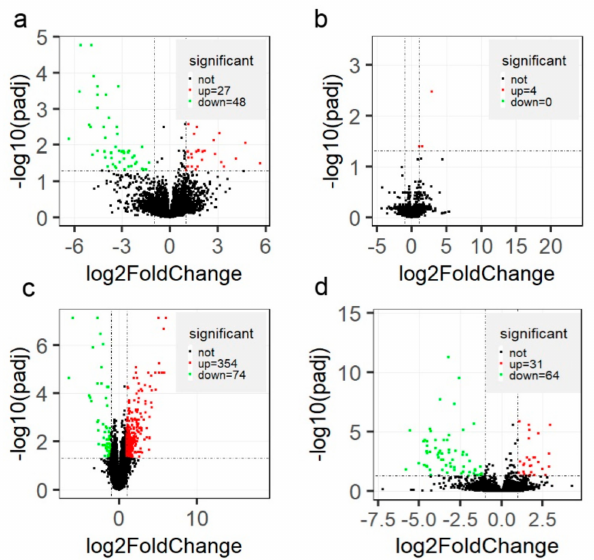
Figure 4. Volcano plot of di ff erentially expressed genes (DEGs) (padj < 0.05 and | log 2 (FoldChange) | > 1) among di ff erent groups. The x-axis represents the log 2 (FoldChange), while y-axis represents statistical significance for each gene. The pairwise comparisons are ketosis at postpartum (CK) versus healthy controls at postpartum (HC) ( a ), ketosis at prepartum (PCK) versus healthy controls at prepartum (PHC) ( b ), HC versus PHC ( c ), and CK versus PCK groups ( d ),